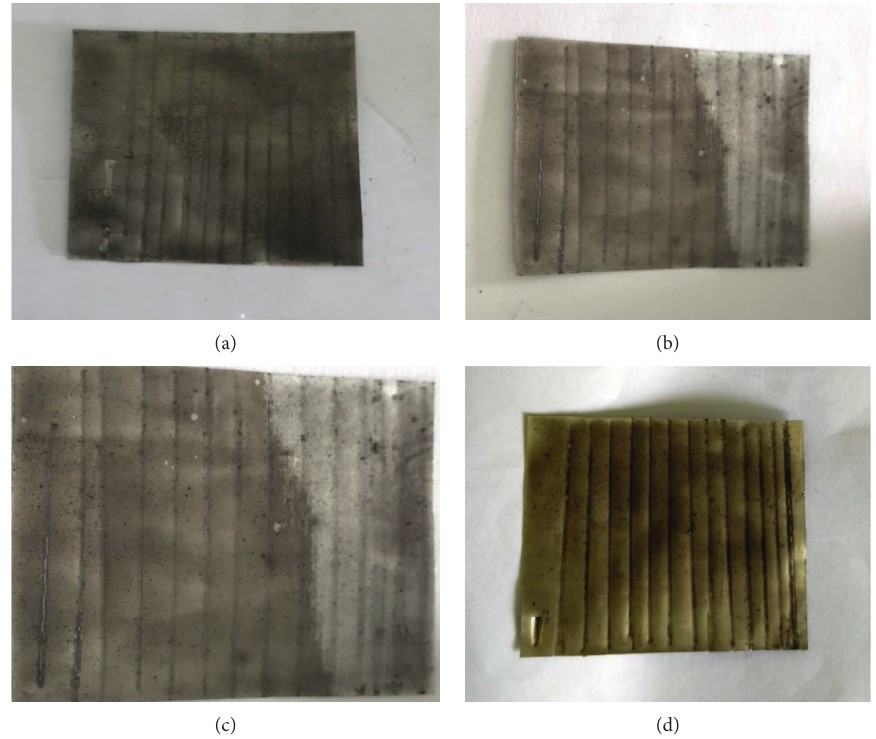
Figure 2: Samples after measuring the hardness. (a) F1 (0.5 wt.% MWCNTs, 10 wt.% FA). (b) F2 (1 wt.% MWCNTs, 10 wt.% FA). (c) F4 (1 wt.% MWCNTs, 0 wt.% FA). (d) F3 (1.5 wt.% MWCNTs, 10 wt.%